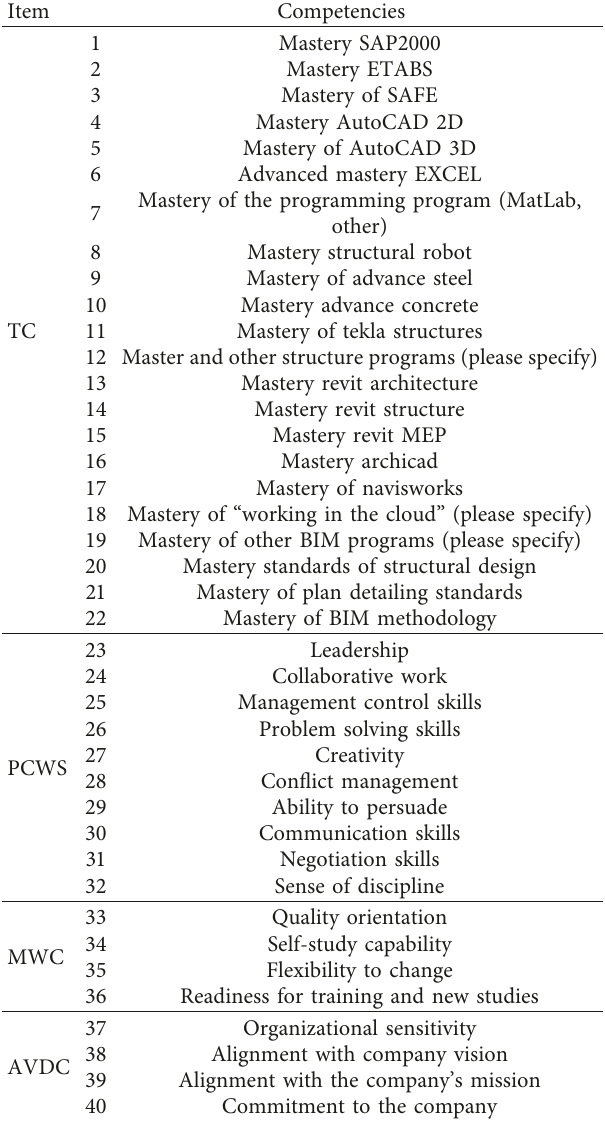
Table 1: Items for measuring human